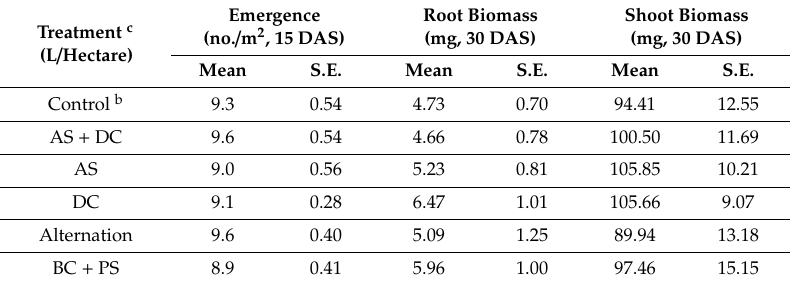
Table 7. The e ffi ciency of the application of the fungicide by dripline irrigation in the field (Amir, summer 2018) a